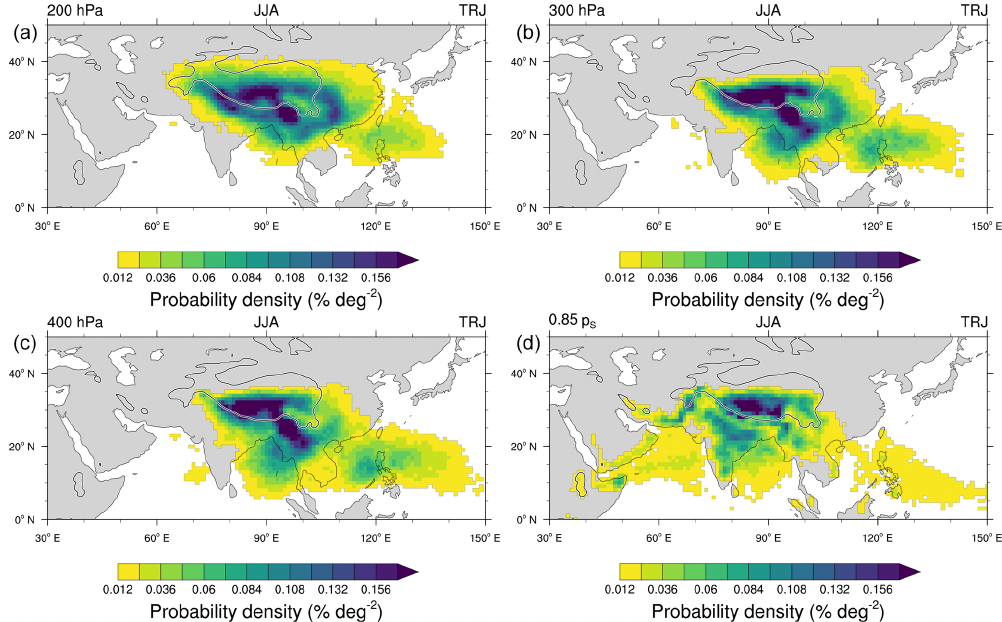
Figure 3. Probability density of upward crossings of trajectories (%deg − 2 ) at (a) 200hPa, (b) 300hPa, (c) 400hPa and (d) the PBL (defined as 0.85 times surface pressure) for trajectories that start within the AMA and cross the PBL (as defined before). As noted before, for the 14 years, the individual distributions have been calculated and averaged afterwards; i.e. each year contributes equally to the probability density (also for subsequent analyses). Here and in the following plots, if the last bin of the colour bar is denoted by a triangle, it contains all values up to the maximum of the field which is